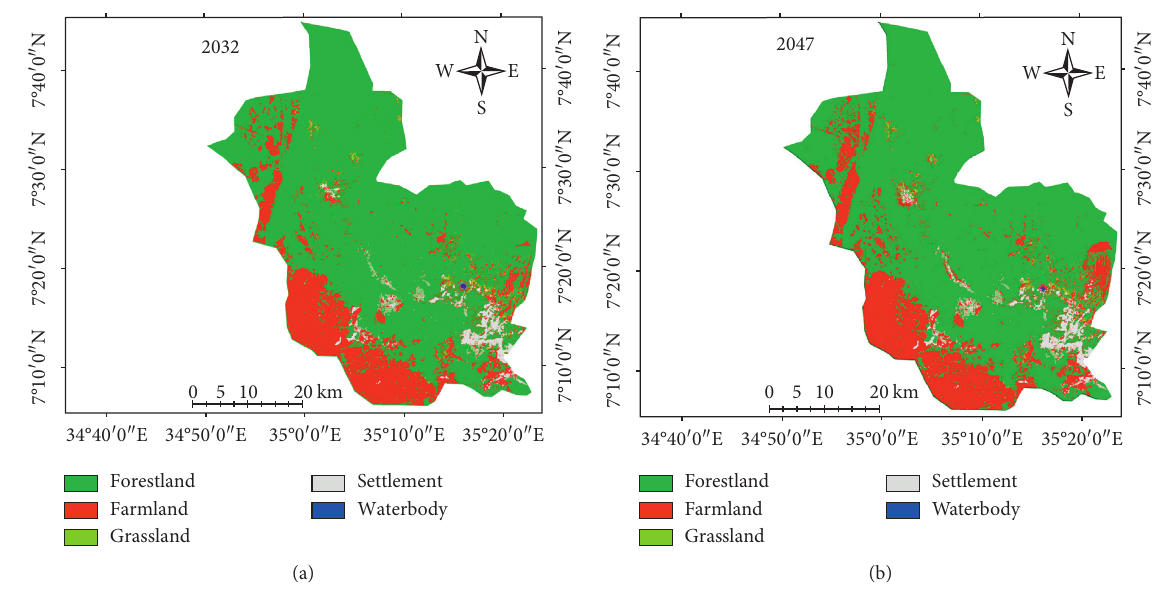
Figure 7: The 2032 and 2047 predicted LULC of MFBR.